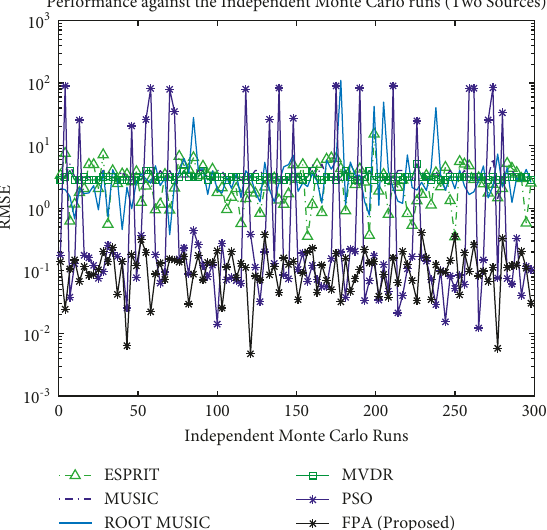
Figure 5: Performance against independent Monte Carlo runs for two sources with 5 dB of